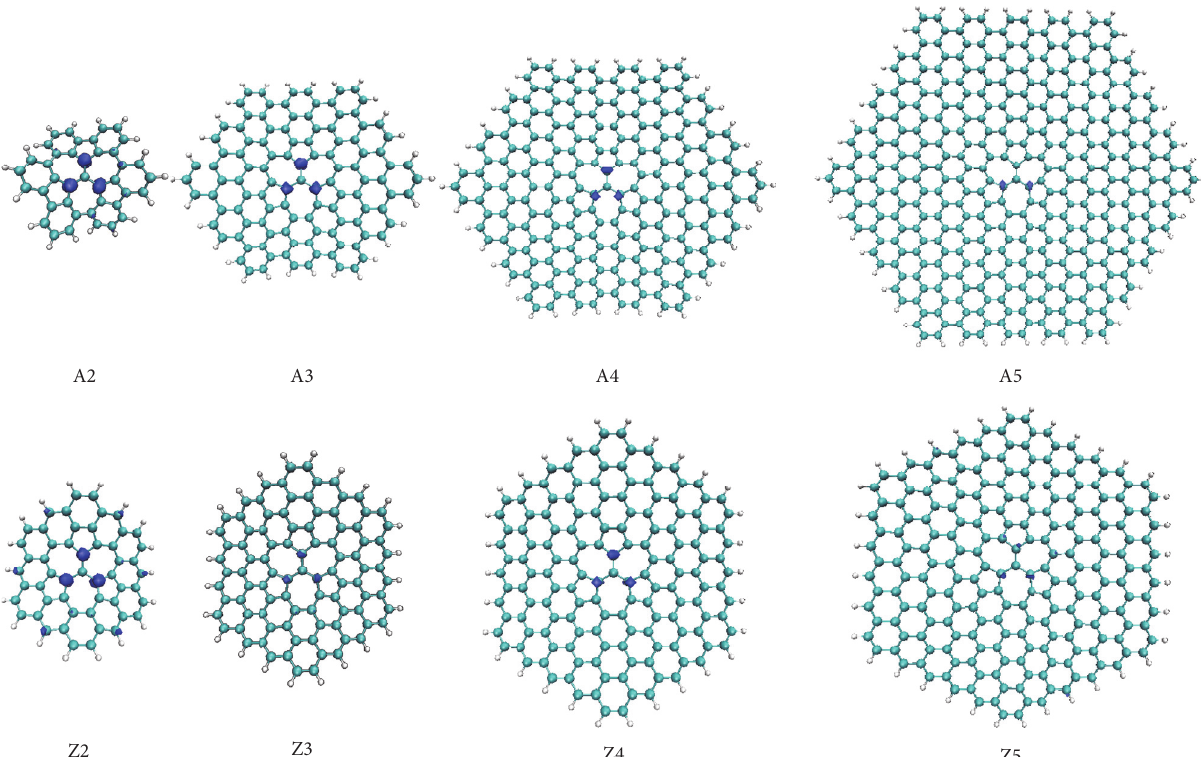
Figure 5: The spin density distributions of the 555777 divacancy defects in the two type edges of HGFs with the isovalue = ±